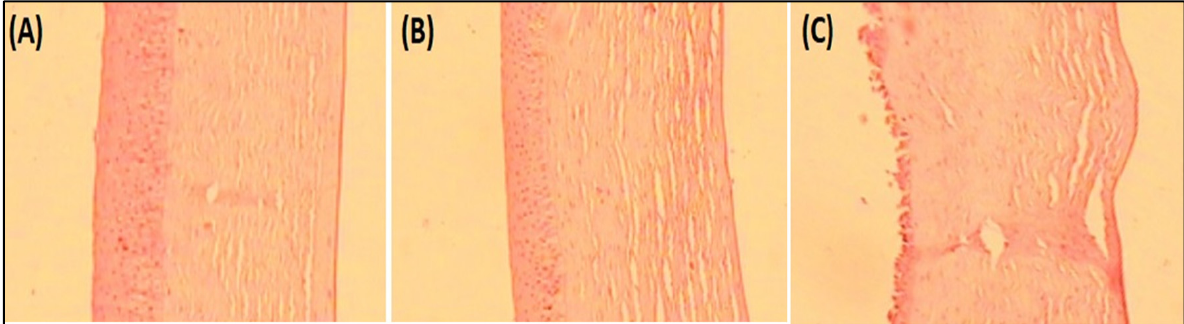
Figure 7. Histopathological image of ( A ). EM-NLCs-opt-IG4, ( B ). Negative control (0.9% NaCl) and ( C ). Positive control as SLS (1% w / v